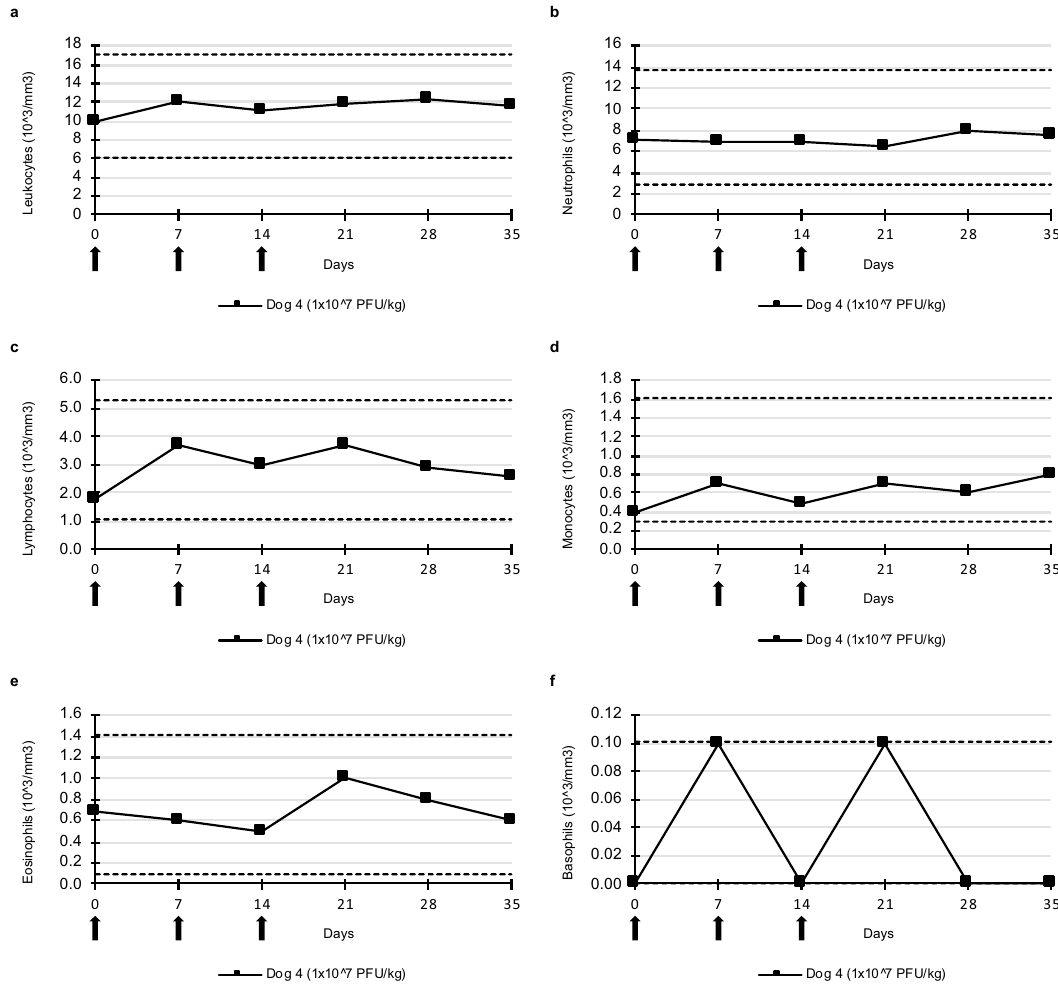
Figure 4. White blood cell count after three intravenous injections of TG6002. ( a) Leukocytes. ( b) Neutrophils. ( c) Lymphocytes. ( d) Monocytes. ( e) Eosinophils. ( f) Basophils. TG6002 did not induce significant changes in any blood cell counts after repeated injections at 1 × 10 7 PFU/kg. Arrows indicate TG6002 administrations. Dotted lines represent reference